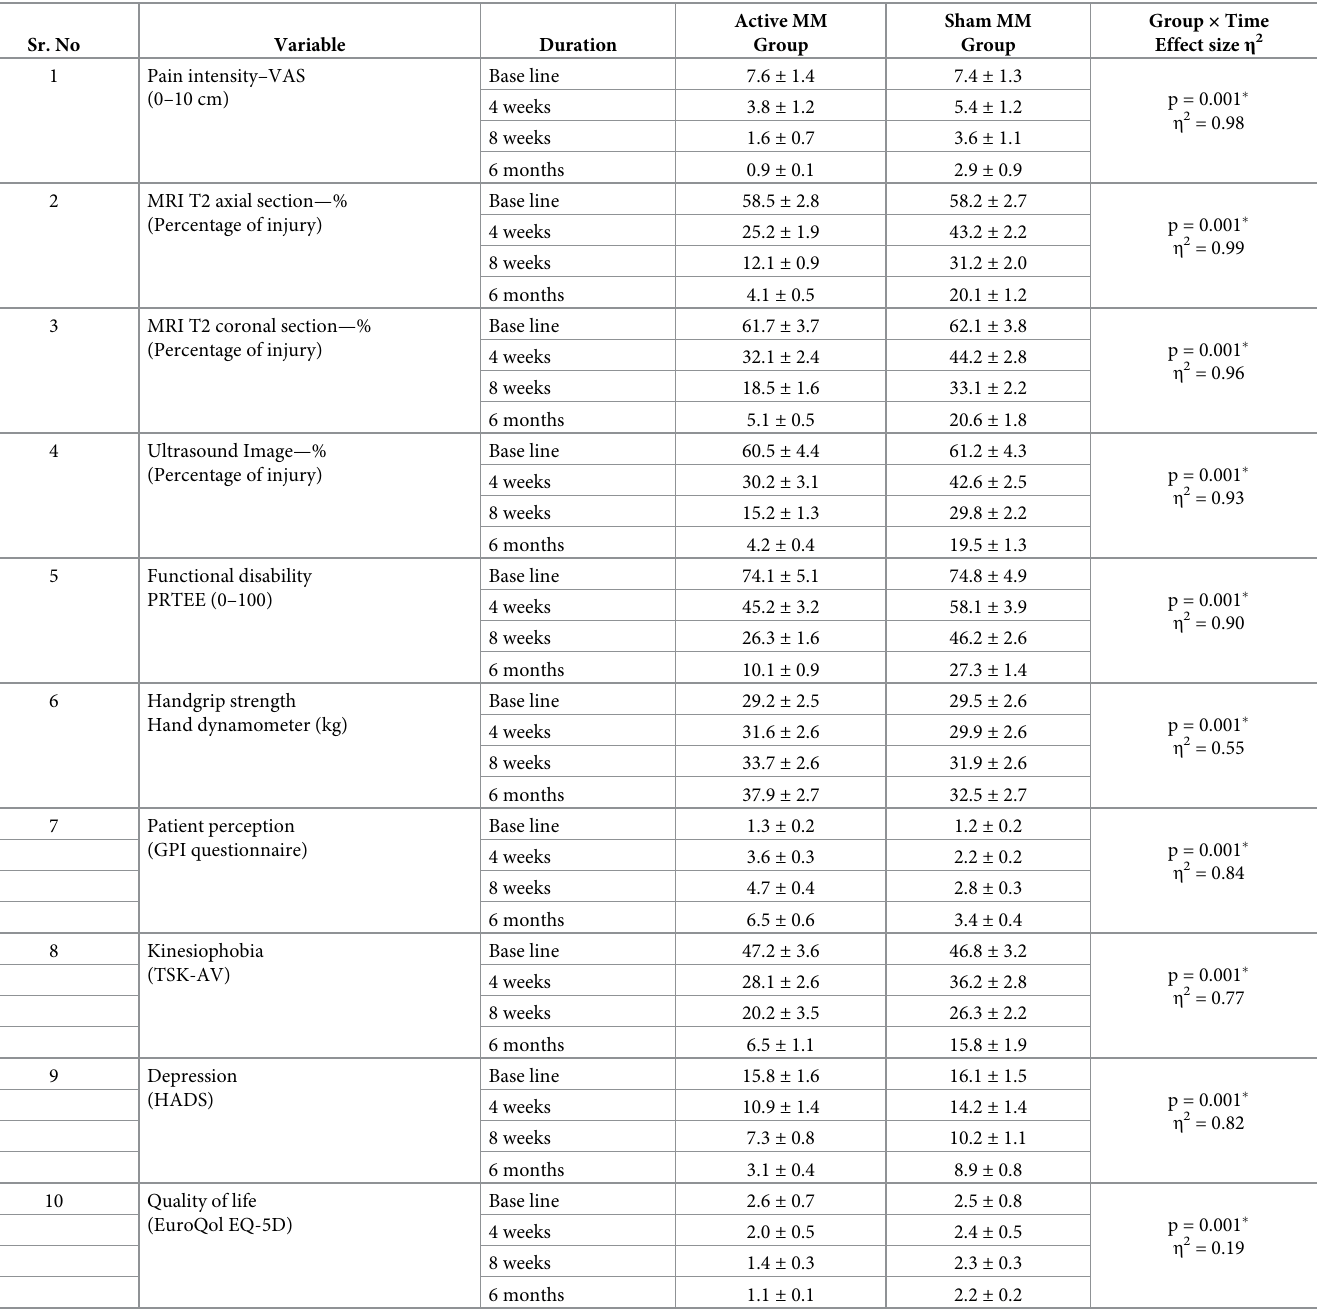
Table 2. Pre and post primary and secondary outcome measures of active and sham MM